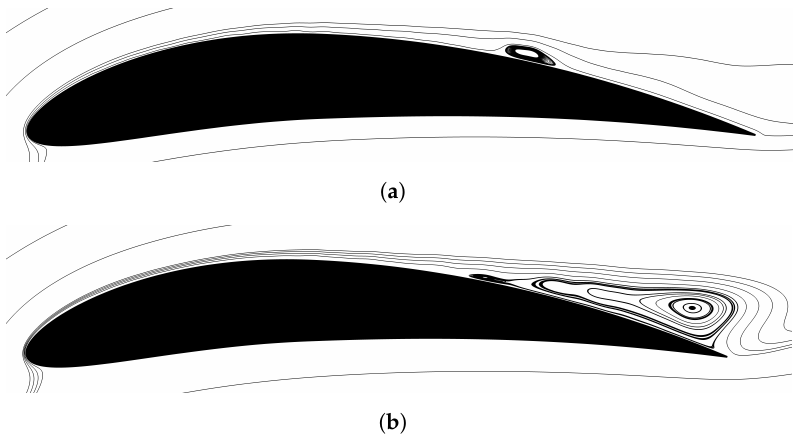
Figure 11. Streamlines of the averaged flowfield for the optimal and maximum lift configurations. ( a ) Streamlines of the averaged flowfield for the optimal configuration. ( b ) Streamlines of the averaged flowfield for the maximum lift